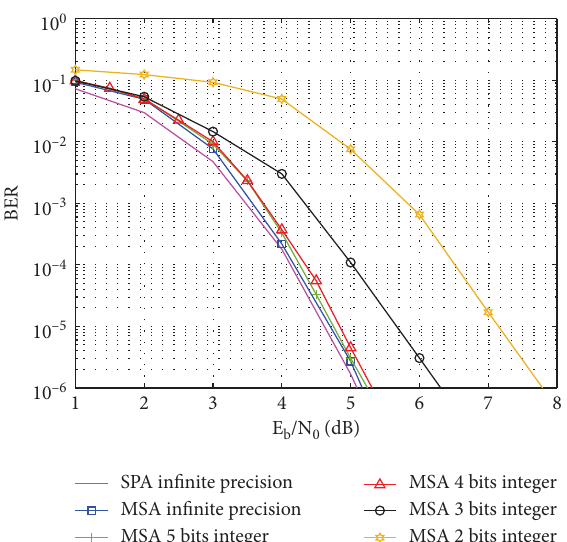
Figure 12: BER performance of MSA LDPC decoding with various quantization schemes. n � 264 and R � 3/4.